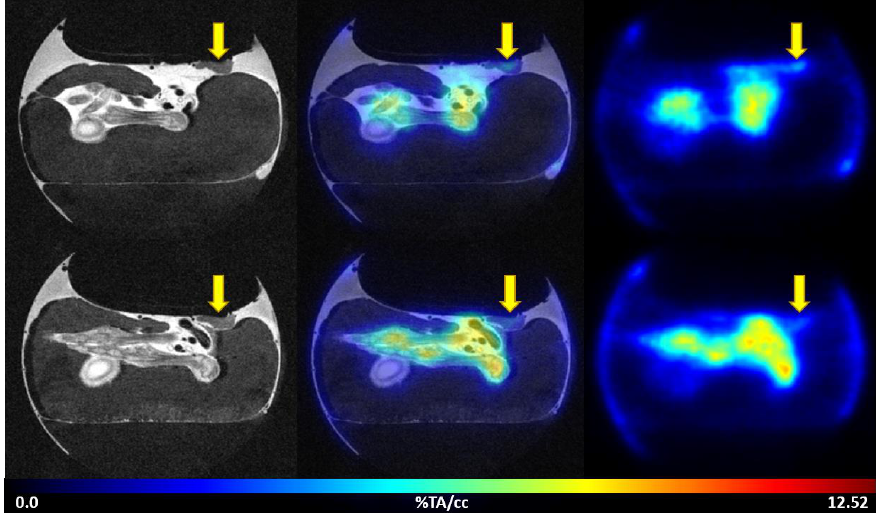
Figure 4. Representative images of [ 68 Ga]Ga-Pentixafor PET/MRI in the HCT116 CAM-xenograft model. Upper row: baseline scan after i.v. injection of 7.19 MBq [ 68 Ga]Ga-Pentixafor (0.79 nmol peptide) on EDD16. Lower row: blocking (315 µg AMD3100/egg) of [ 68 Ga]Ga-Pentixafor uptake (18.32 MBq, 3.12 nmol peptide) in the same subject on the following day (EDD17). Left: T2-weighted TurboRARE images, right: [ 68 Ga]Ga-Pentixafor PET 60 min p.i., middle: fused PET/MRI (axial planes are shown). HCT116 CAM-xenografts are marked with a yellow arrow.